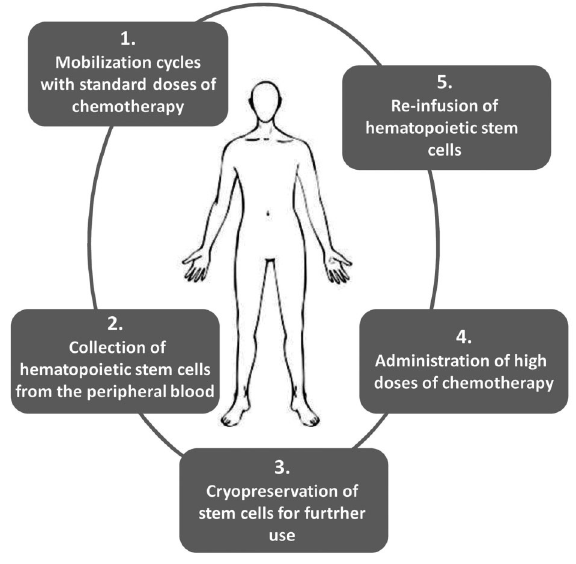
Figure 1. Autologous peripheral blood stem-cell transplant process. High-dose chemotherapy (HDCT) carries significant bone marrow toxicity, which leads to the necessity of autologous hematopoietic stem cell harvest and transplantation during treatment intensification. The use of peripheral blood as a source of stem cells for hematopoietic stem cell transplant rather than bone marrow greatly contributed to the application of HDCT in the treatment of solid tumors. This procedure simplified the harvest of stem cells and considerably decreased morbidity and mortality associated with HDCT, decreasing length of hospitalization and reducing treatment costs. Furthermore, the use of hematopoietic growth factors allowed increased cytotoxic dosing. The granulo- cyte colony-stimulating factor (G-CSF) is administrated to accelerate leukocyte recovery after